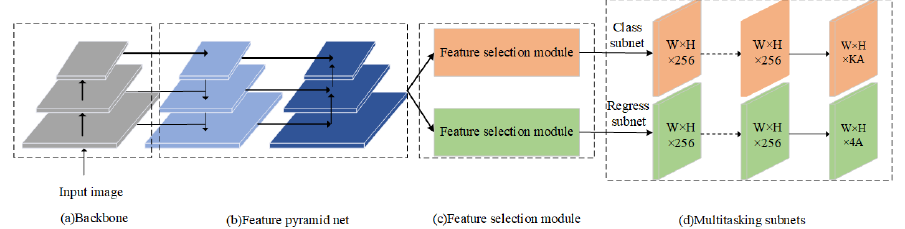
Figure 1. The network structure of the proposed method can be divided into four parts: ( a ) input image, ( b ) feature pyramid net, ( c ) feature selection module, ( d ) multitasking